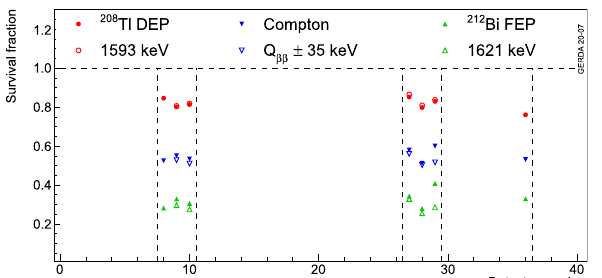
Fig. 15 Survival fractions of events in the 208 Tl DEP, 212 Bi FEP and CC( Q ββ ) for each coaxial detector after ANN and risetime cuts. Open (filled) symbols show the calibration dataset before (after) the 2018